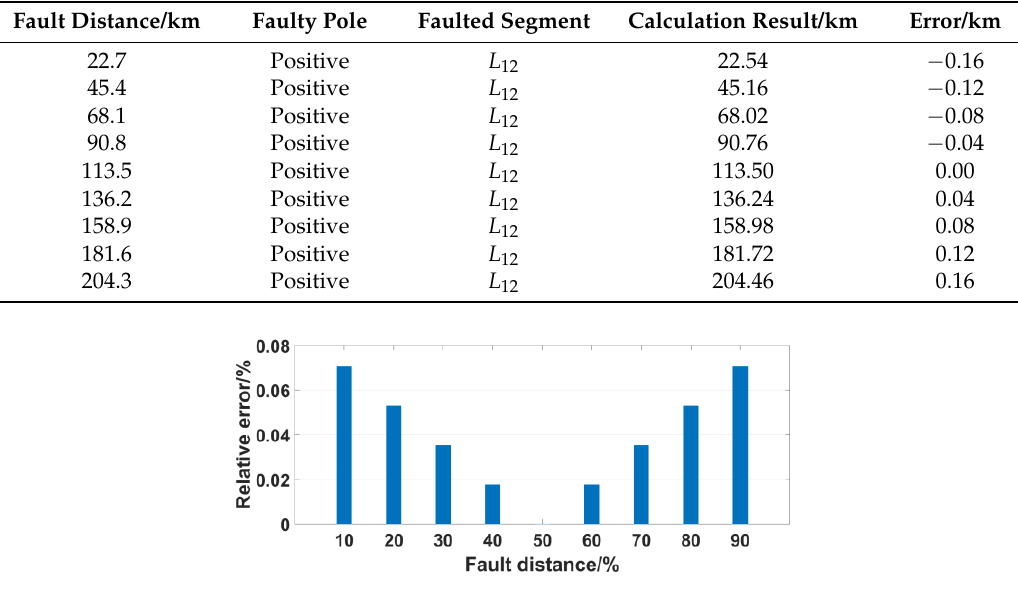
Table 7. Location results of fault with different fault distances.